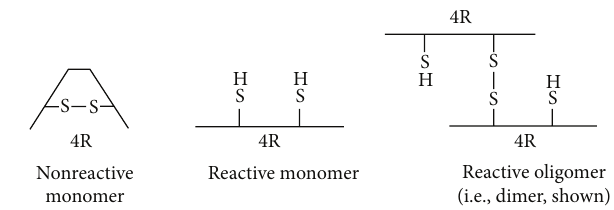
Figure 2: Schematic of nonreactive monomer, reactive monomer, and reactive oligomer. Reactivity implies the ability to form an intermolecular disulfide linkage. Intramolecular disulfide linkage causes formation of nonreactive tau monomer. The free thiols in a reactive monomer allow formation of an intermolecular or intramolecular disulfide linkage. Reactive oligomer has one or more free thiols readily forming disulfide linkage with reactive monomeric tau for the oligomer extension